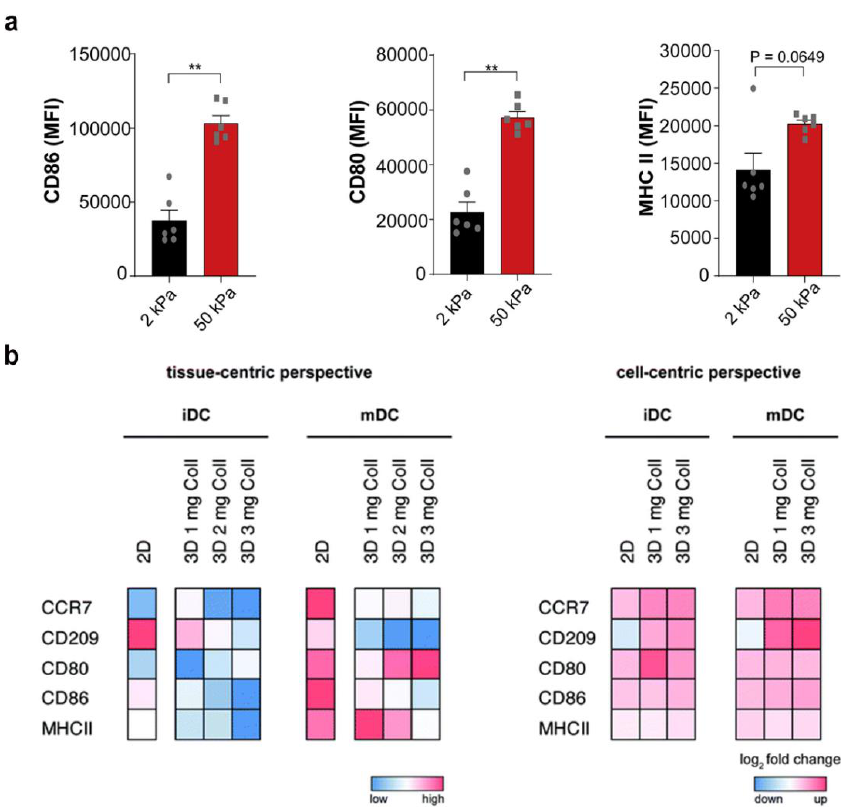
Figure 18. Dimensionality and stiffness modulate DC phenotype. ( a ) Surface expression of CD80, CD86, and MHC class II from BMDCs on PDMS substrate in which black dots and white squares correspond to the different test values that BMDCs on 2 kPa and 50 kPa, respectively. (* p < 0.05, ** p < 0.01, *** p < 0.001 as determined by Mann-Whitney U test) (reprinted/adapted with permission from Ref. [17], 2021, Chakraborty et al.). ( b ) DC immune phenotype on 2D and 3D collagen hydrogels (reprinted/adapted with permission from Ref. [12], 2020, Sapudom et